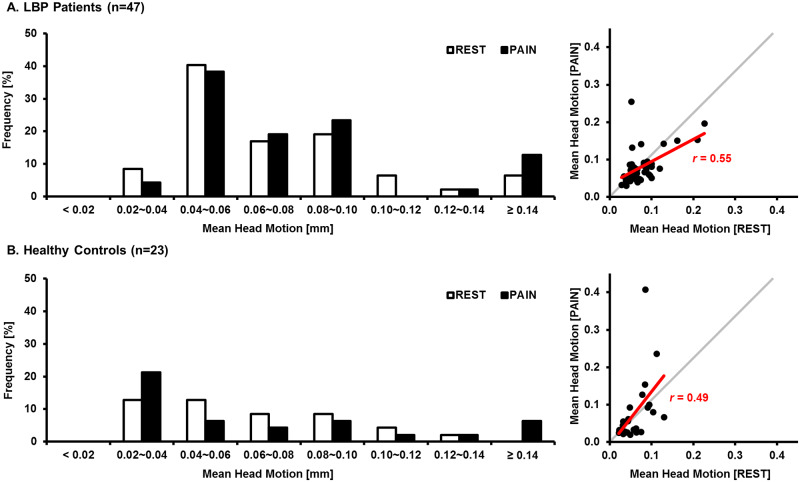
Comparison of the head motion between the REST and the PAIN in the LBP patients and the HC.Histogram of the mean head motion of the LBP patients (A, left) and HC (B, left). The white bars indicate head motion in the REST, while the black bars indicate head motion in the PAIN. The scatterplots compare the mean head motion between the REST and the PAIN in the LBP patients (A, right) and HC (B, right). In both groups, the head motion parameters in the REST and the PAIN were positively correlated (r = 0.55 and r = 0.49 respectively).